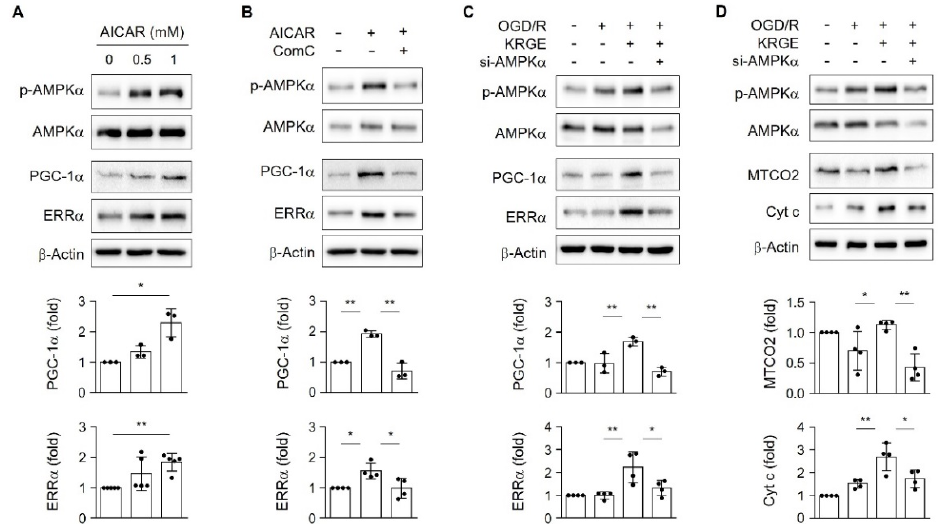
Figure 4. AMP-activated protein kinase α (AMPK α ) regulated KRGE-mediated peroxisome proliferator-activating receptor- γ coactivator-1 α (PGC-1 α ) and estrogen-related receptor α (ERR α ) expression. ( A ) When astrocytes reached 90% confluency, the culture media were replaced with serum-free Dulbecco’s Modified Eagle Medium (DMEM). After 1 h, the cells were treated with 0, 0.5, or 1 mM 5-aminoimidazole-4-carboxamide-1- β -D-ribonucleoside (AICAR) for 4 h. The expression of indicated proteins was detected via Western blotting. ( B ) When astrocytes reached 90% confluency, culture media were replaced with serum-free DMEM. After 1 h, the cells were pretreated with 10 µ M Compound C (ComC) for 15 min and treated with 1 mM AICAR for 4 h. The expression of indicated proteins was detected via Western blotting. ( C , D ) Astrocytes were transfected with 50 nM control or 50 nM AMPK α siRNA (si-AMPK α ) and subjected to OGD/R followed by treatment with 250 μ g/mL KRGE. Indicated protein levels were analyzed using Western blotting and quantified. ( A – D ) n = 3–5 independent experiments. * p < 0.05; ** p < 0.01.